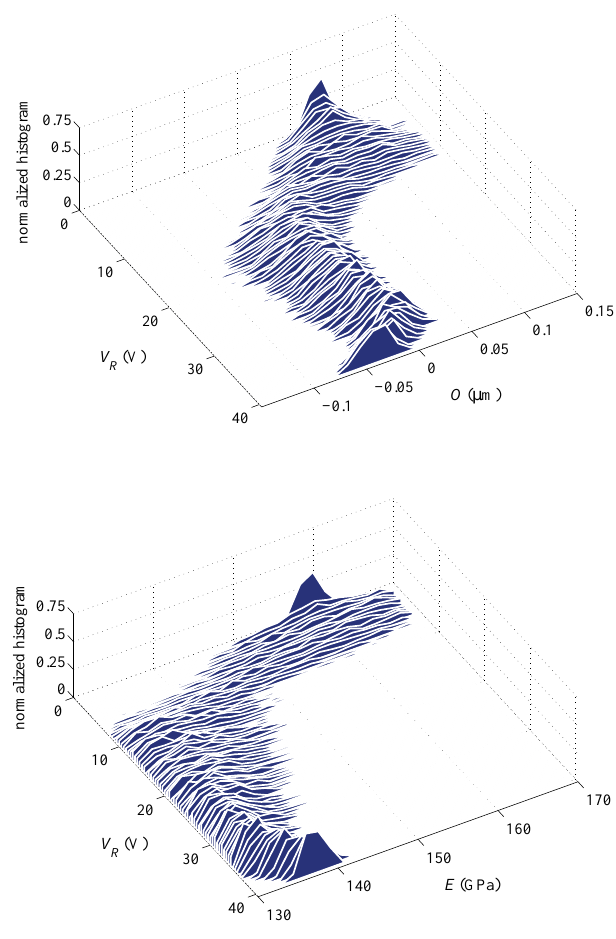
Figure 8. Specimen #2, rotational actuation case, ξ O = ξ E = 0.75: evolution of the PDFs of ( a ) O and ( b ) E corresponding to the evolution of estimates represented by blue curves in Figure 7a.